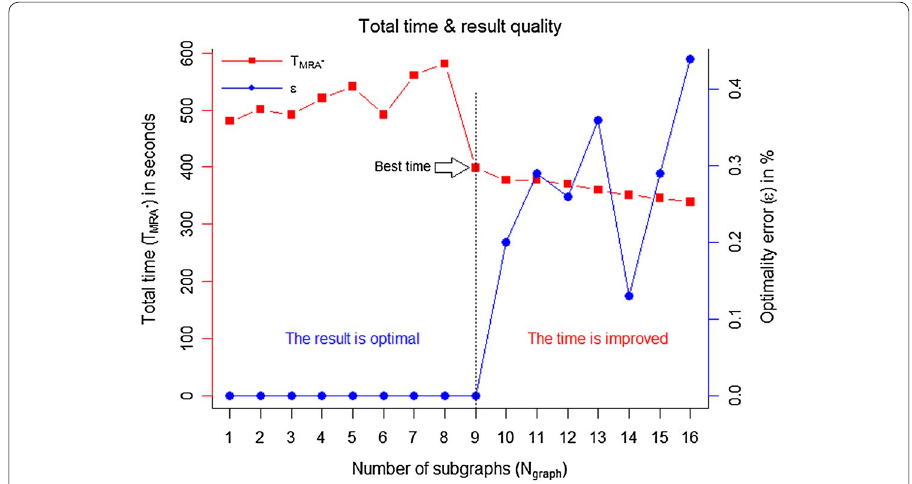
Fig. 13 Impact of number of subgraphs on the computational time and the result quality